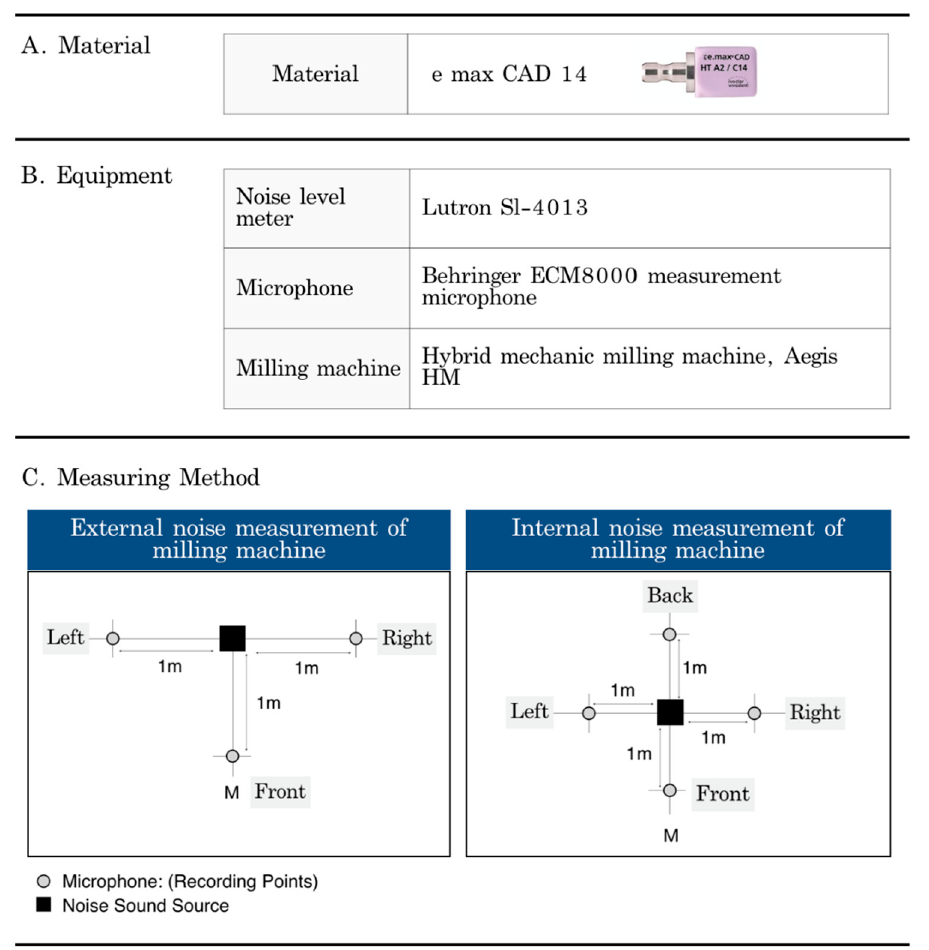
Figure 3. Experimental scheme. ( A ) material; ( B ) equipment; ( C ) measurement method.